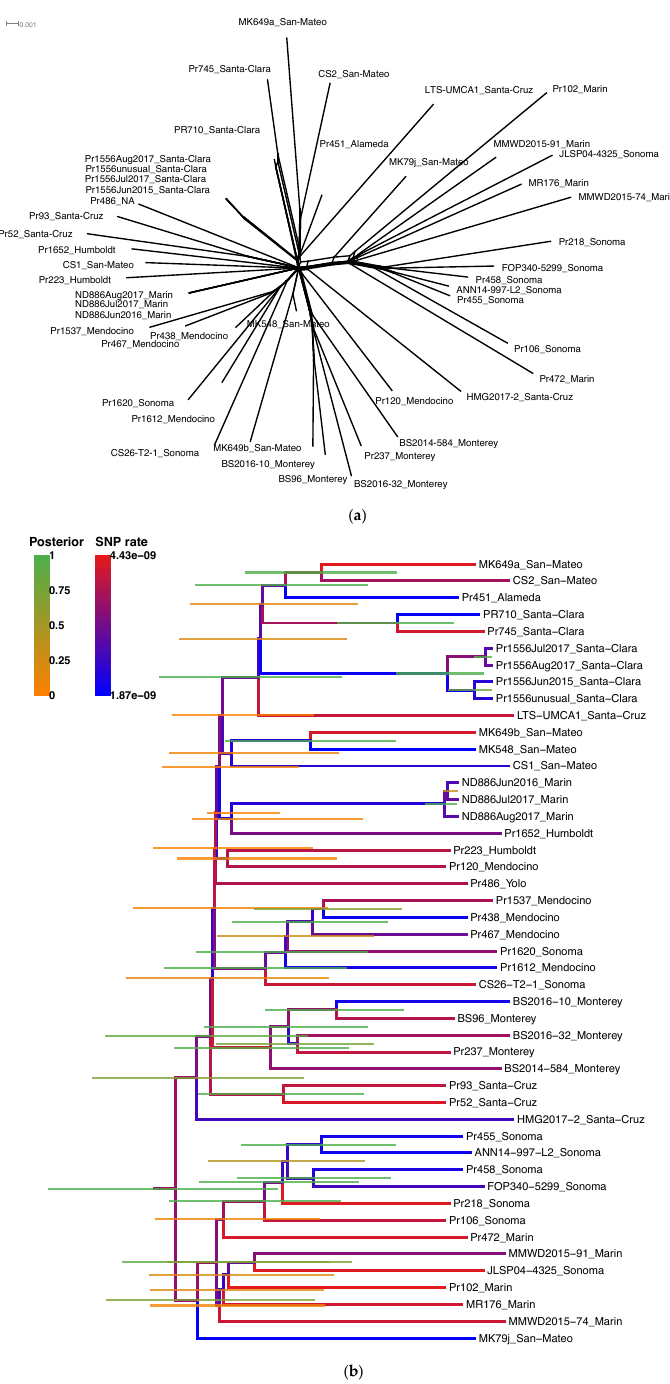
Figure 2. Phylogenetic reconstruction of P. ramorum NA1 in California. ( a ) Splitstree graph using SNPs indicates resolved relationships and discordances as links between branches; ( b ) phylogeny using BEAST v1.8.0 under the Birth–Death serial sample model. Node labels are the posterior probabilities of node height and line color represent posterior support of SNP mutation rate. Isolate identification numbers are followed by the California county of origin and naming conventions are consistent with previous publications. The first letters of the identification number represent the original project or the collector (e.g., BS = Big Sur project, and MMWD = Marin Municipal Water District). Pr1556 and ND886 served as controls during sequencing and the dates following their name indicate the time they were sequenced (e.g., August 2017).